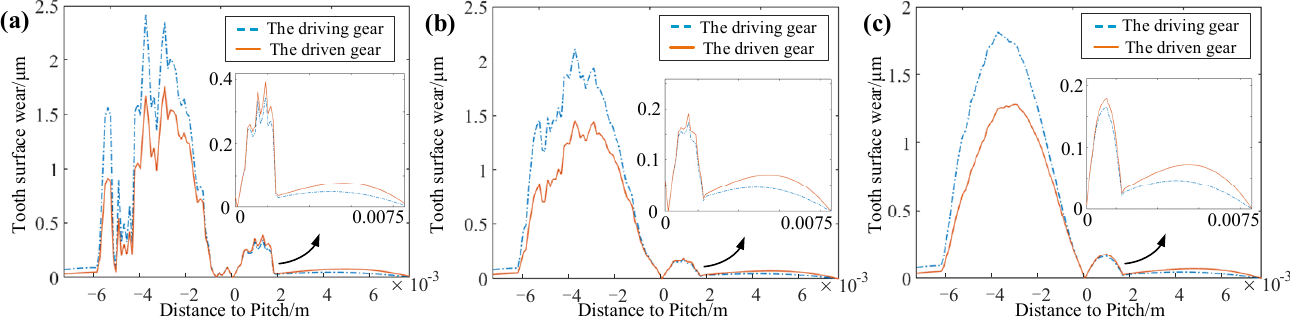
Figure 9. Initial tooth surface wear. ( a ) D = 1.43. ( b ) D = 1.5. ( c ) D = 1.6.